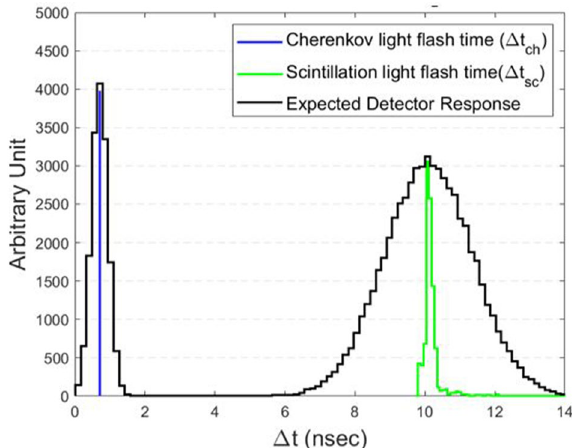
Figure 4. Cherenkov and scintillation light flash time. Cherenkov light flashing time has a fast pulse (< 1 × 10 –9 s) because it is the result of instant physical disorder caused by the incident muon whereas scintillation light flash time has a slow distribution with a tail due to the decay constant ( ≫ 1 × 10 –9 s) because it is a fluorescence process of scintillation.